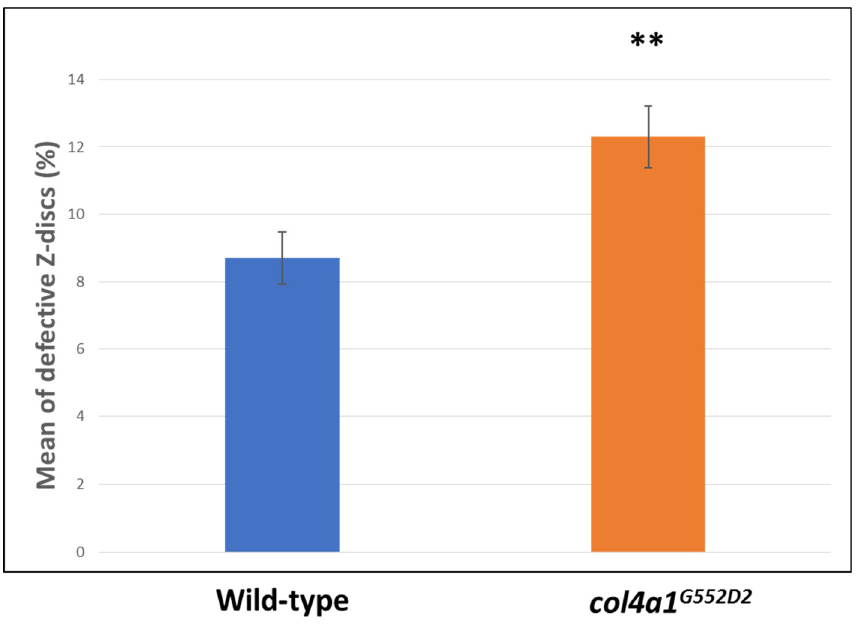
Figure 2. Elevated expressivity of Z-disc shifting in mutants. Statistically significant expressivity of Z-disc shifting in the mutants at p = 0.003973 (**).